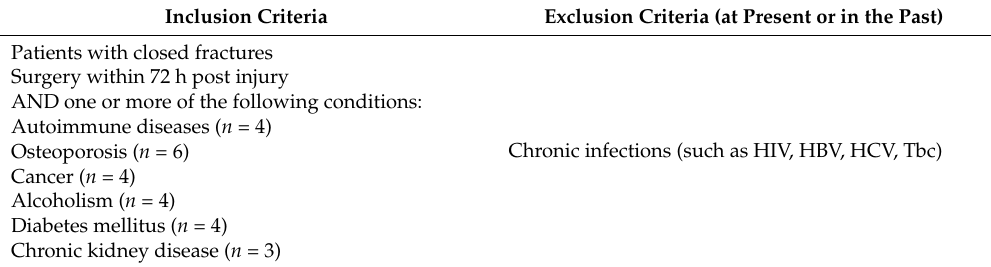
Table 2. Inclusion and exclusion criteria for patients defined as immunologically restricted patients, the number of patients matching the inclusion criteria is